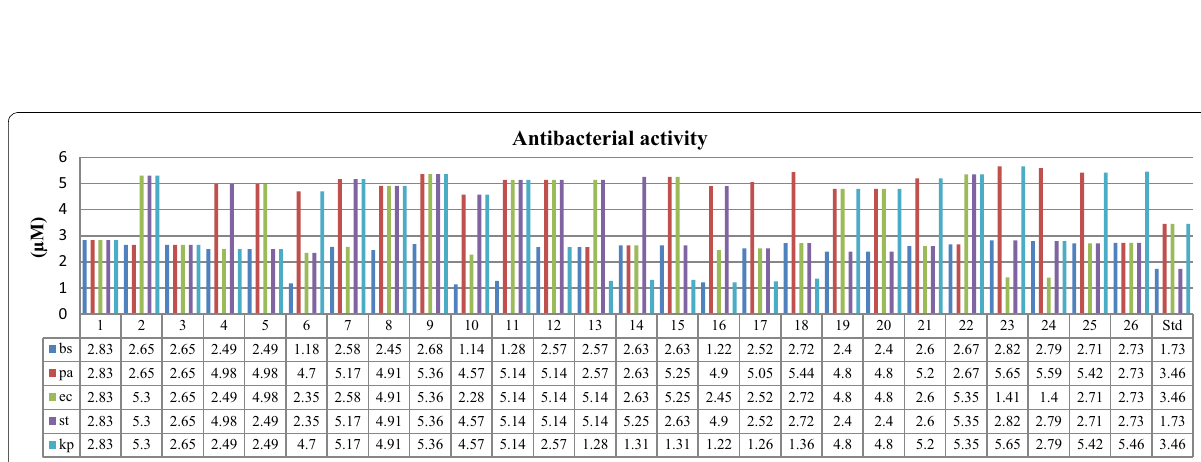
Fig. 3 Antibacterial screening results against Gram positive and Gram negative